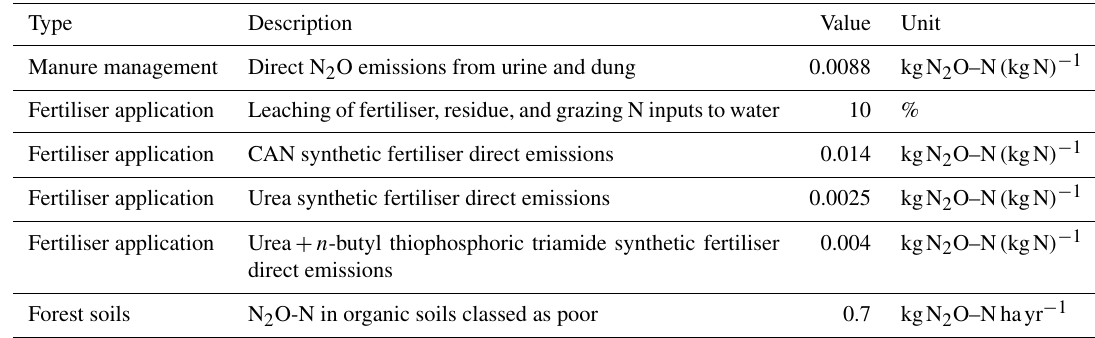
Table 4. Ireland-specific emissions factors derived from national inventory reporting (NIR) utilised in GOBLIN